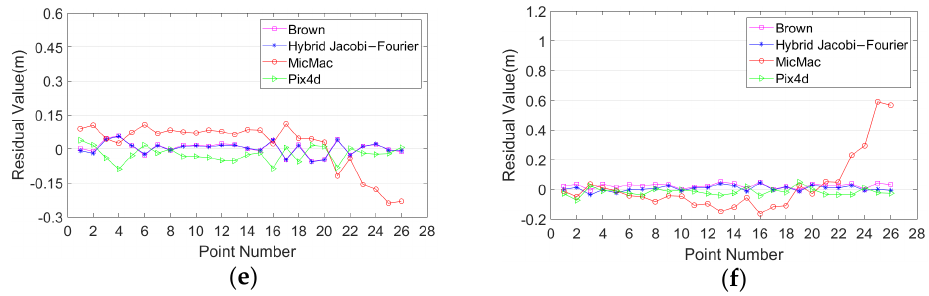
Figure 14. The residuals of check points after self-calibration with one single GCP for test site 2. ( a , c , e ) The residuals of check points of rectangle dataset in the direction of X, Y, and Z, respectively; ( b , d , f ) the residuals of check points of S-shaped dataset in the direction of X, Y, and Z, respectively.